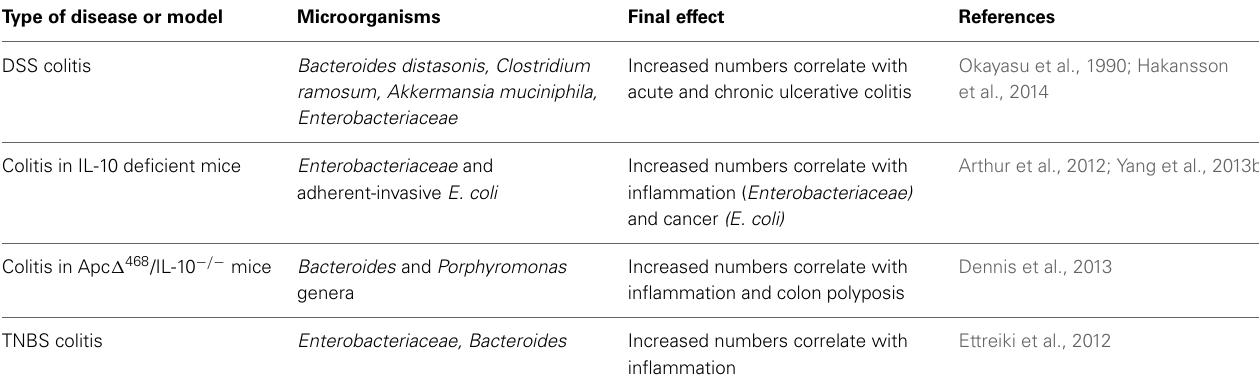
Table 1 | Microorganisms reported to associate with IBD in the